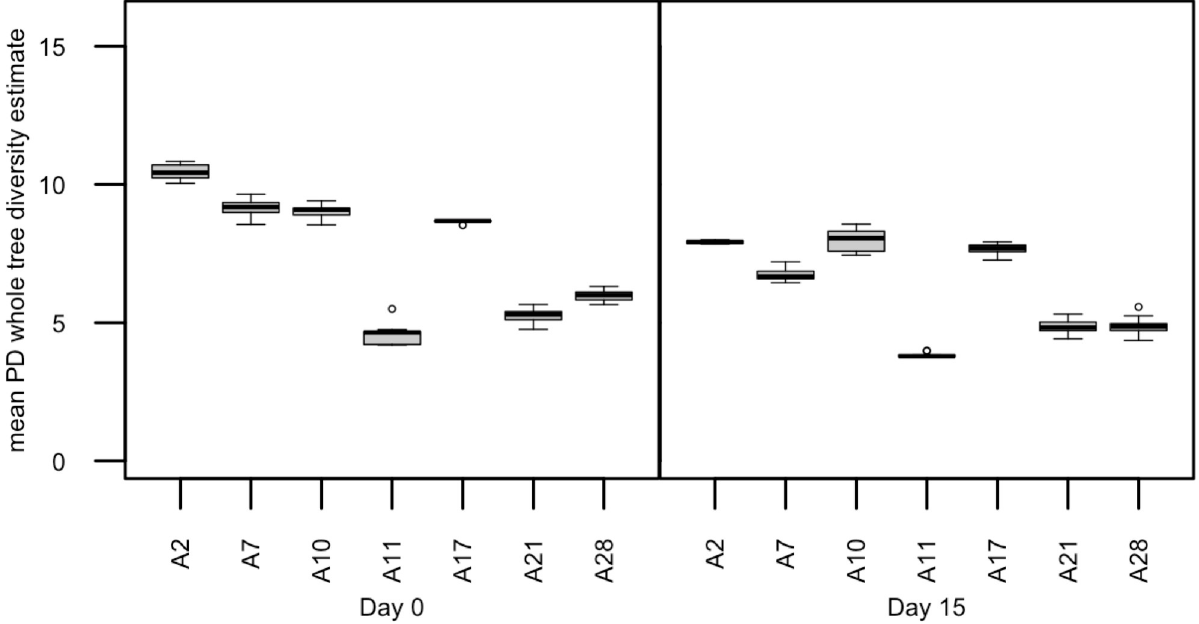
Fig 7. Comparisons of PD whole tree alpha diversity of lead dosed male anoles’ fecal microbiome at day 0 and day 15.